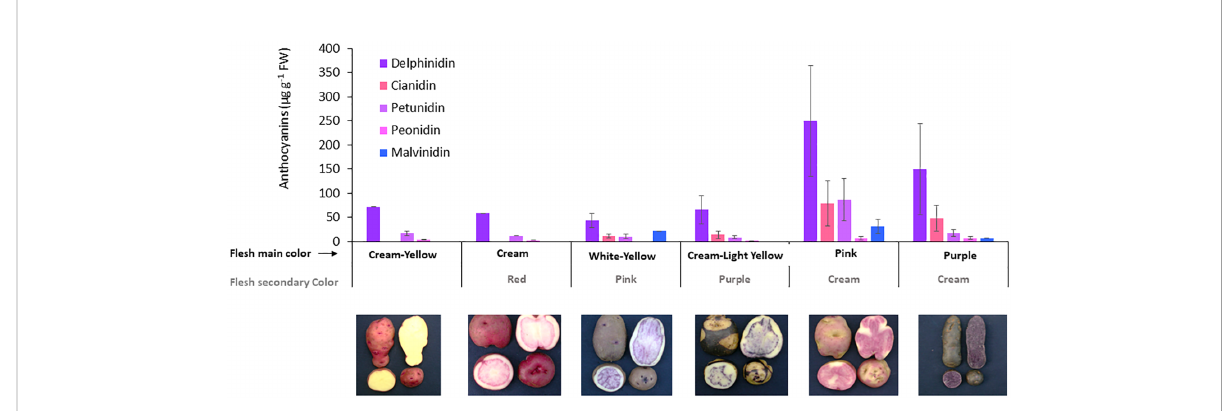
FIGURE 4 Anthocyanin pro fi le in tubers for accession groups with different fl esh color. The number of accessions for each group represented in the fi gure is cream-yellow = 2; cream/red = 1; white-yellow/pink = 6; cream-light yellow/purple = 4; pink/cream = 7; and purple/cream = 5. The X axis shows the combinations of primary and secondary colors in the fl esh according to how accessions were grouped. Images show one accession representative of each